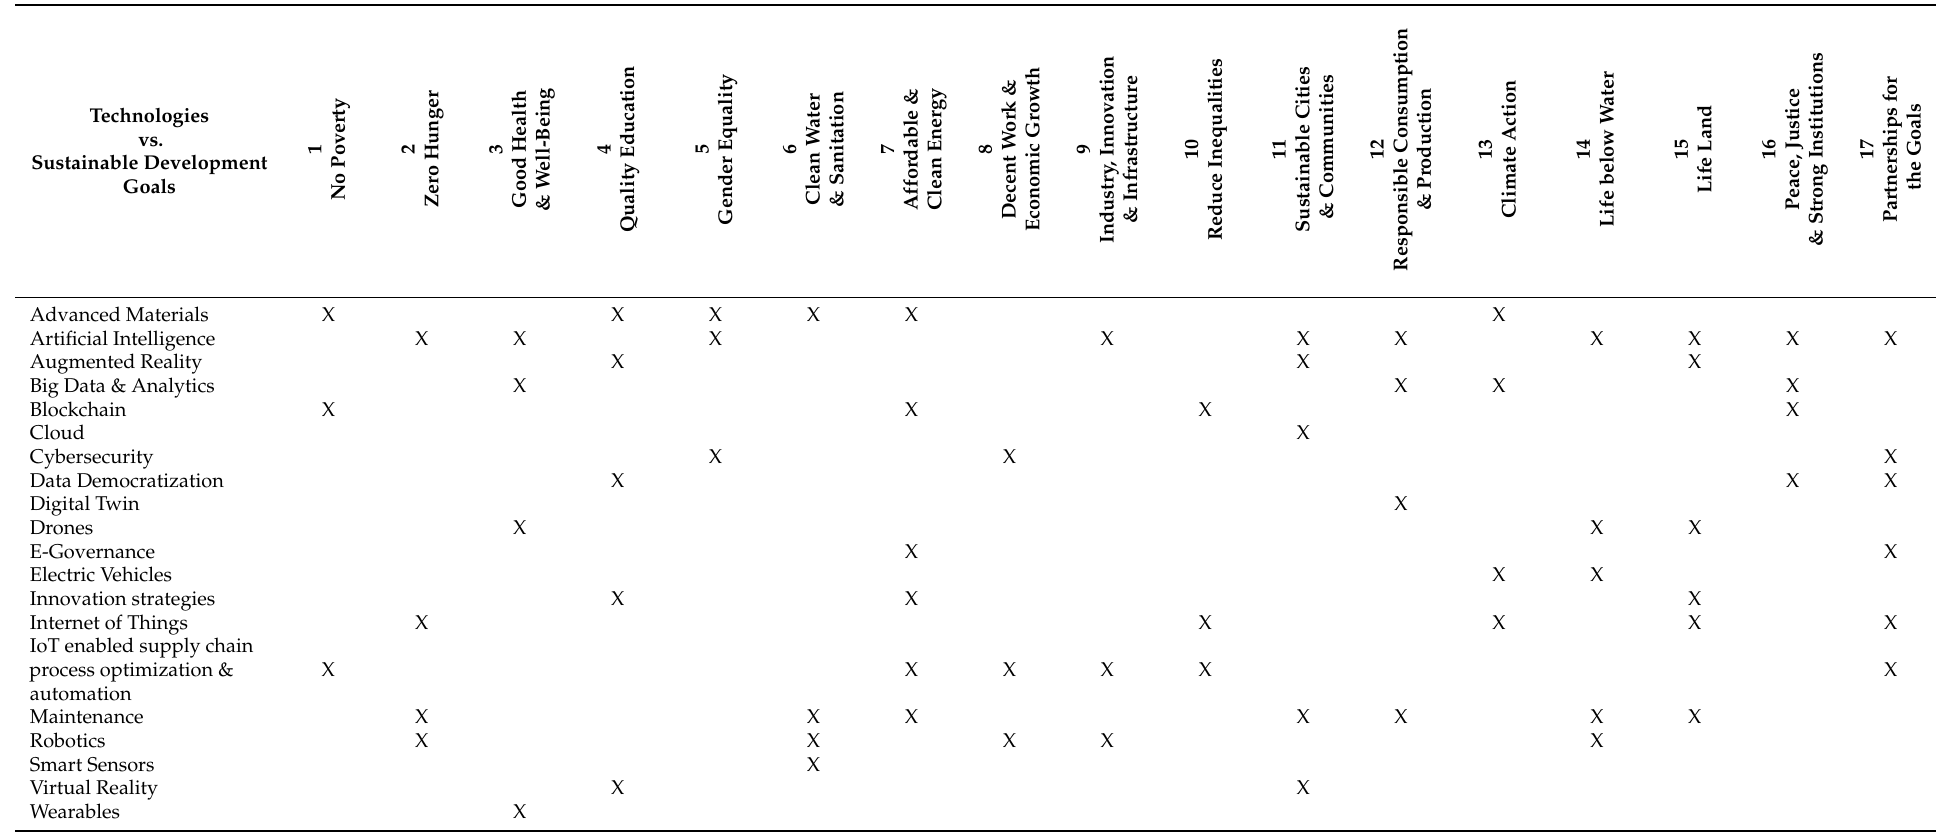
Table 9. Sustainable Development Goals link with Industry 5.0 & Society 5.0 Key